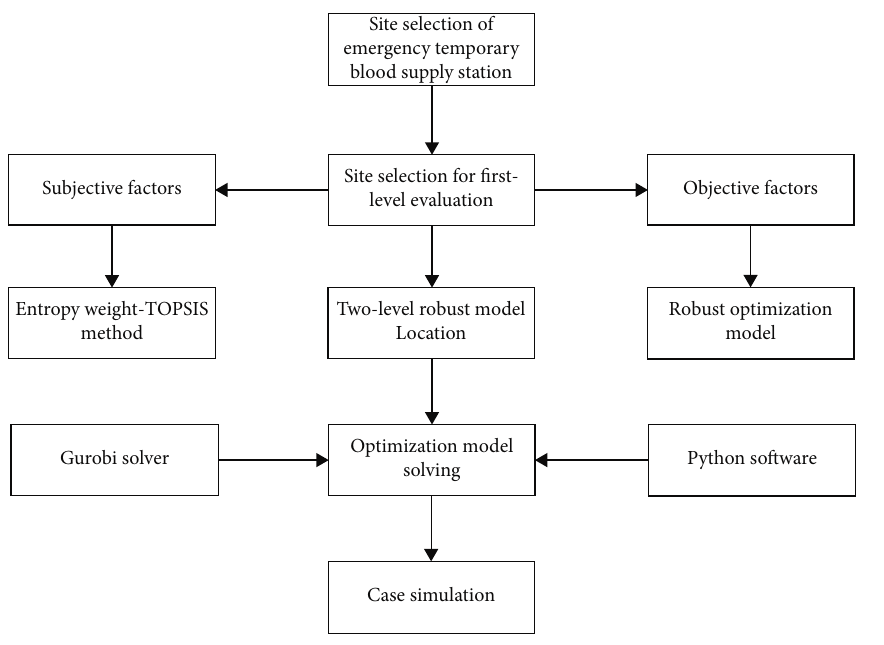
Figure 1: Research